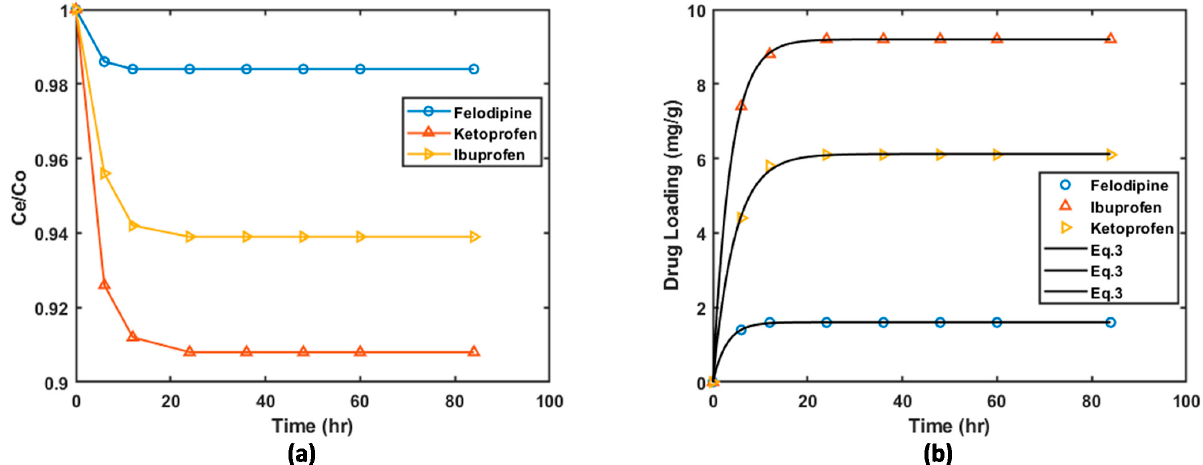
Figure 5. Drug loading kinetics of ibuprofen, ketoprofen, and felodipine onto graphene oxide (GO) ( a ) fraction of drug remaining of felodipine, ketoprofen, and ibuprofen onto GO ( b ) amount of drug load as function of time.